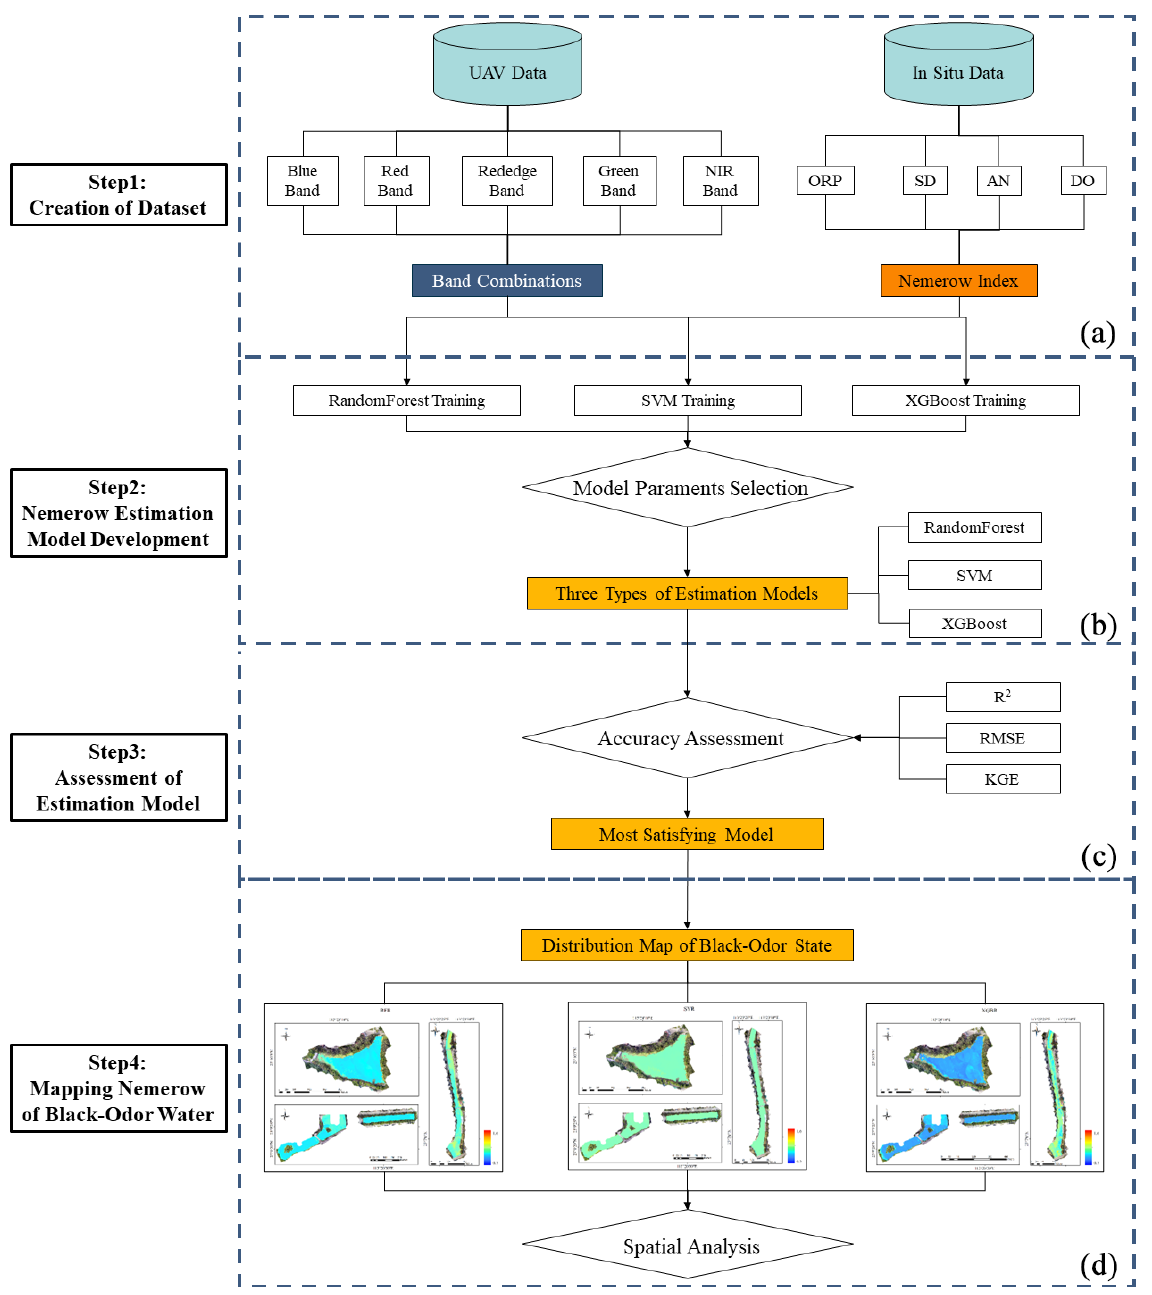
Figure 1. Framework of the NCPI inversion model developed in the study. ( a ) Step 1. ( b ) Step 2. ( c ) Step 3. ( d ) Step